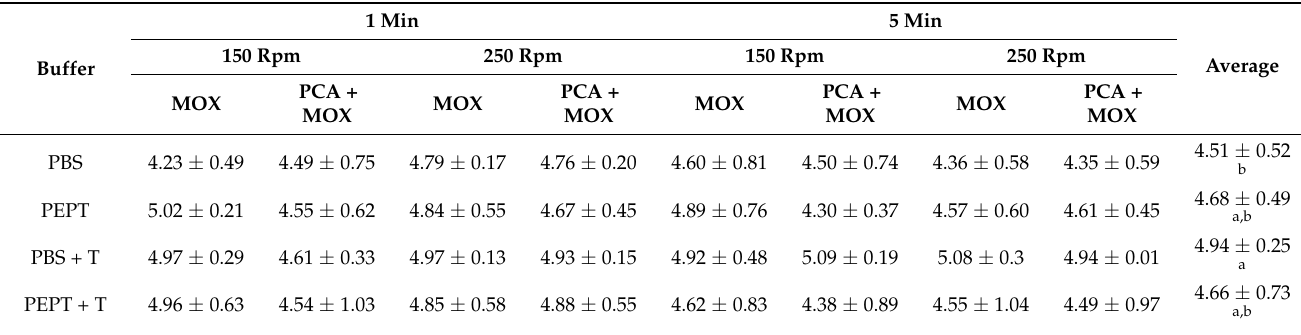
Table 2. L. monocytogenes population (log CFU) recovered from papaya surface as affected by homogenization buffer, time (min), speed (rpm) and enumeration methods *.